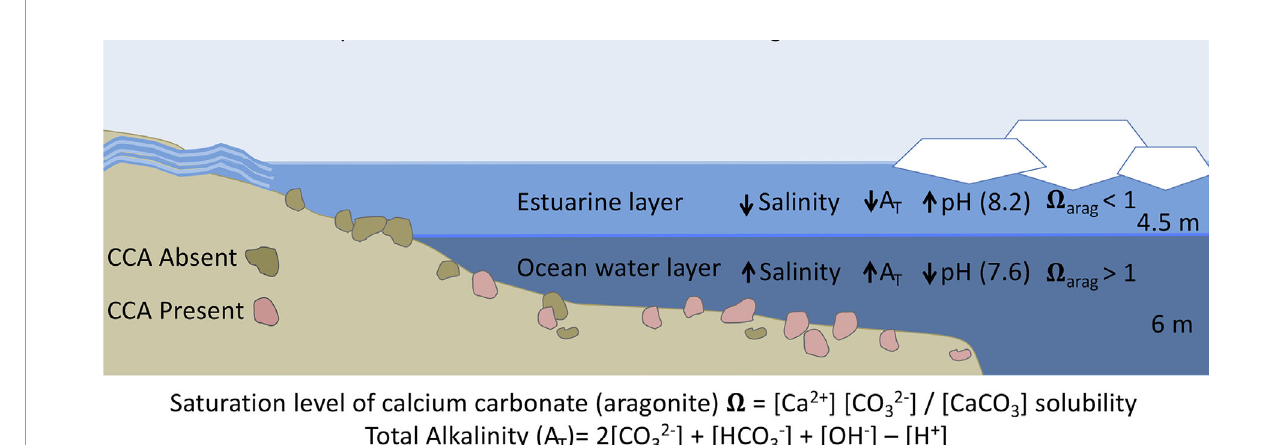
FIGURE 5 | Conditions during ice break-up in the nearshore inner shelf region of the Beaufort Sea. Freshwater input from rivers peaks while remnant sea-ice reduces wave action and mixing, creating a strati fi ed water column with a less dense brackish or estuarine water layer over cold, dense ocean water. Benthic regions within the freshwater layer experience low salinity and alkalinity conditions, driving down the aragonite saturation state, causing dissolution of the CCA populations. Lower salinity water (5 – 15) is de fi ned by decreased A T values (1900 m mEq L − 1 ) than ocean water (>30 and 2,400 m mEq L − 1 ). Lower A T values decrease the numerator in the W equation, depressing W Arag levels. This process is independent of pH, as river water pH is higher than ocean water in many near-shore Arctic systems. As break-up continues, wind driven mixing occurs, creating a homogenous water column for the summer and ice-covered